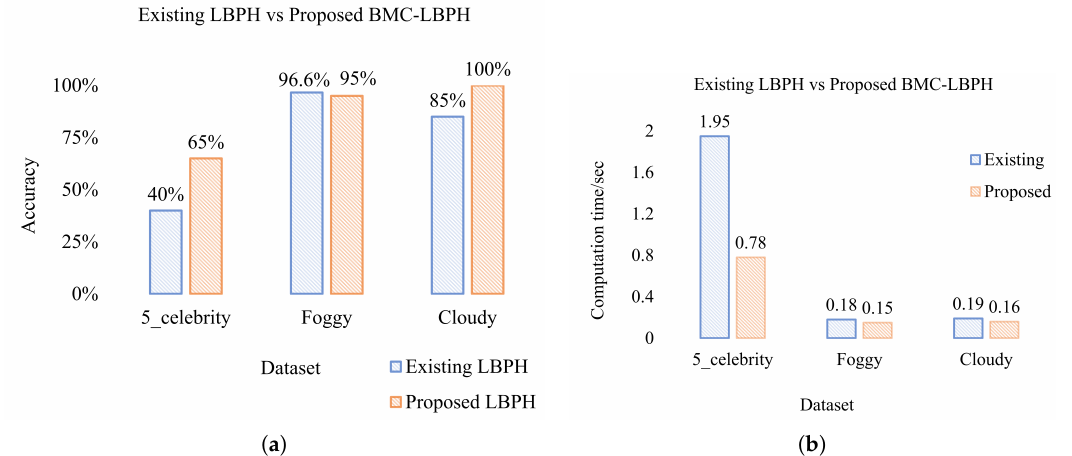
Figure 6. Comparison between LBPH and BMC-LBPH FR techniques in terms of ( a ) accuracy and ( b ) computation time on both dataset.